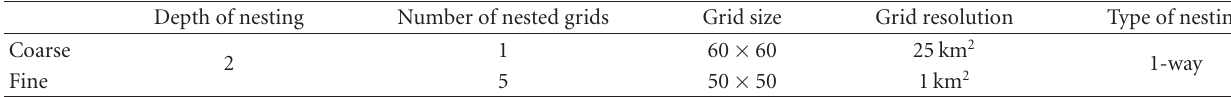
Table 1: Description of MEMO and MARS-aero nested grids.